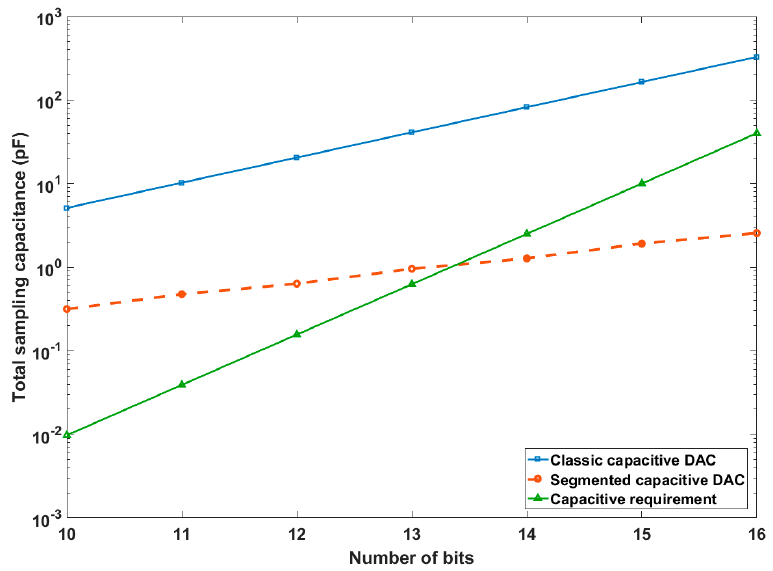
Figure 2. Total capacitance for a non-segmented or segmented DAC, and the optimum requirements to limit kT / C noise.